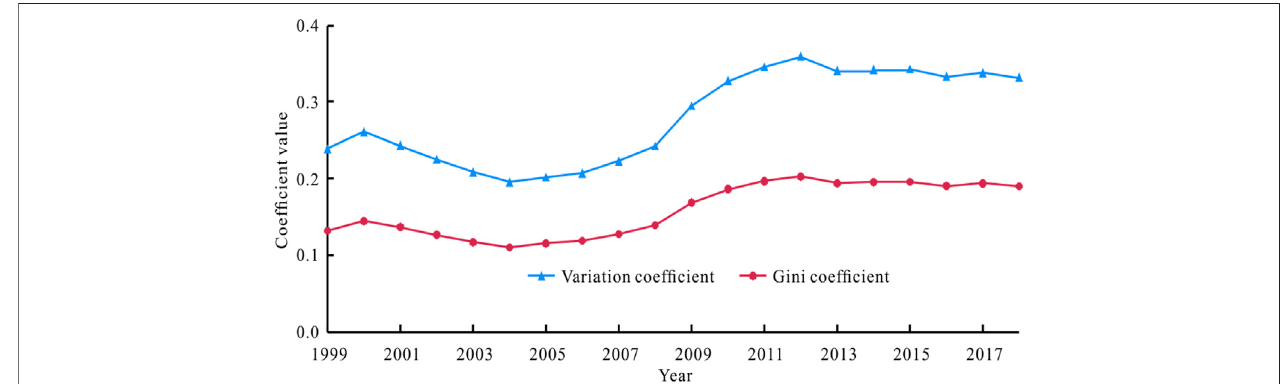
FIGURE 3 | The CV and Gini coef fi cient of regional agricultural eco-ef fi ciency from 1999 to 2018.